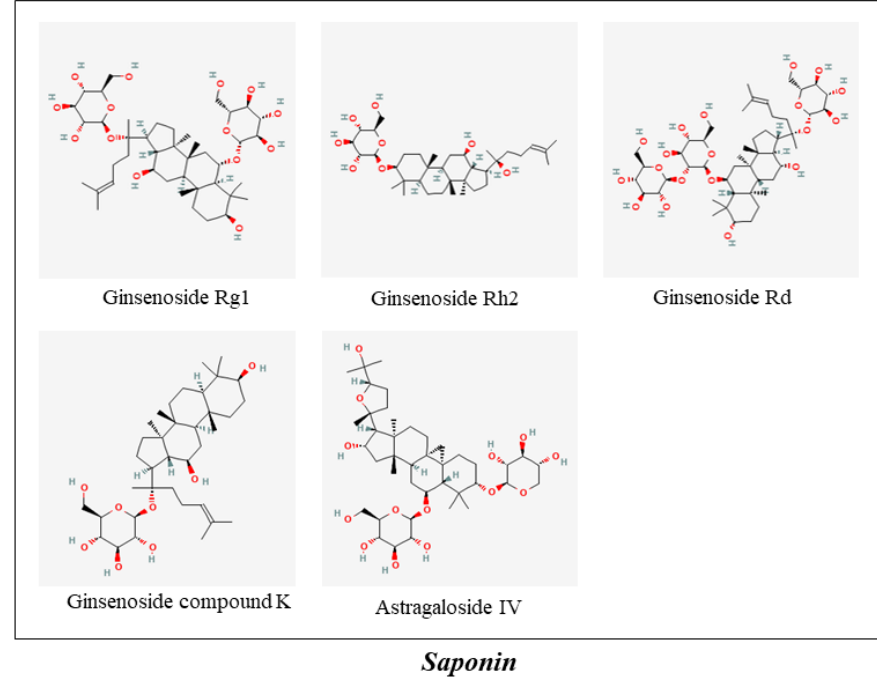
Figure 4. The ingredients of Saponin in